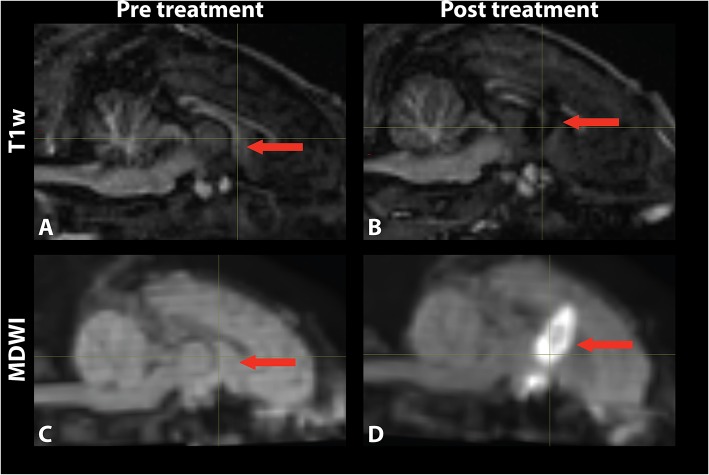
Mid-sagittal (A,B) T1-weighted and (C,D) MDWI images before and after MRgFUS treatment for a single subject. The target area appeared hypointense in the T1w image and hyperintense in the MDWI image after treatment.